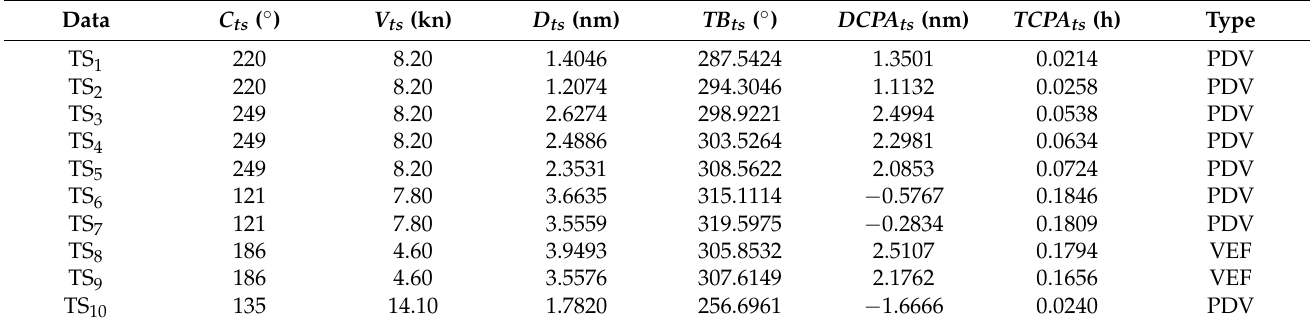
Table 9. Data of target ships at 0016.